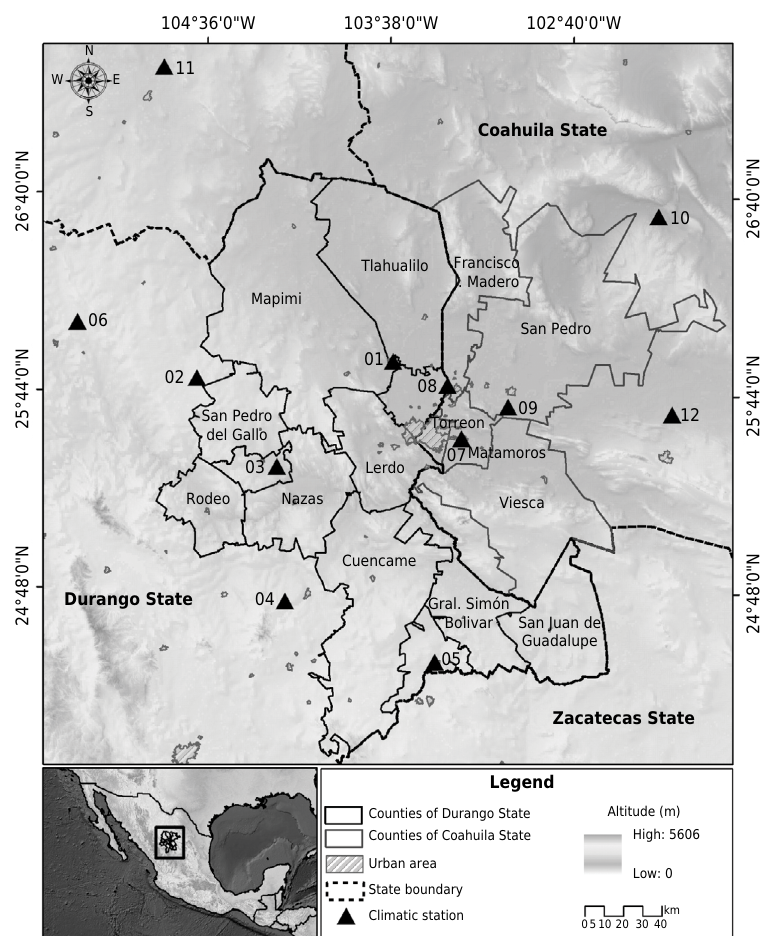
Figure 1. Study area and location of weather stations. Numbers correspond to names listed in table 2.